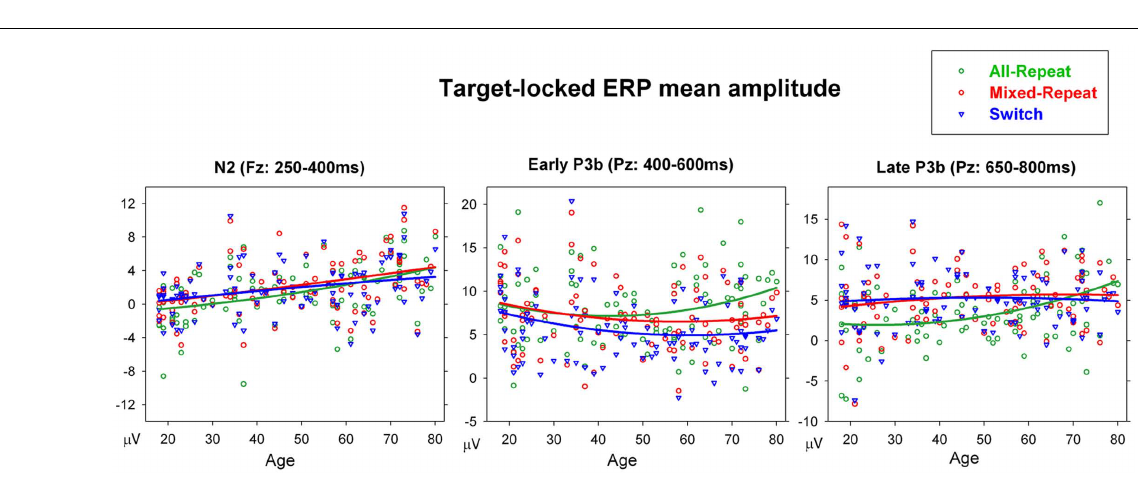
N2 was significantly smaller frontocentrally for mixed-repeat than all-repeat trials [mixing: F (1,92) = 5.55, p = 0.021;